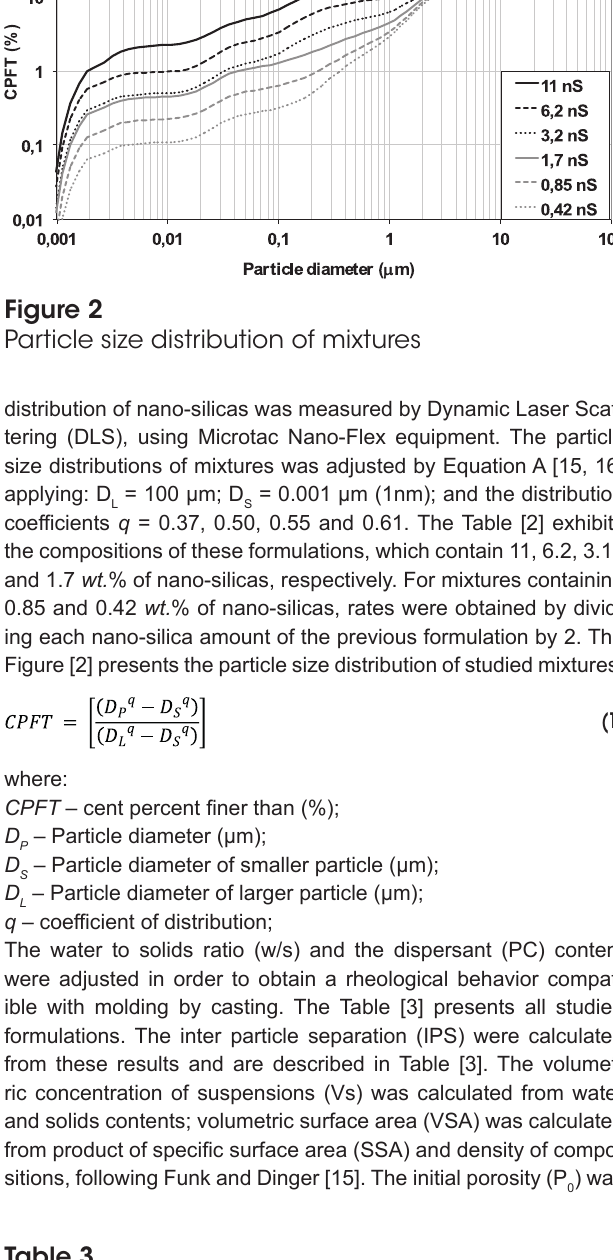
Composition and physical characteristics of suspensions Mixture